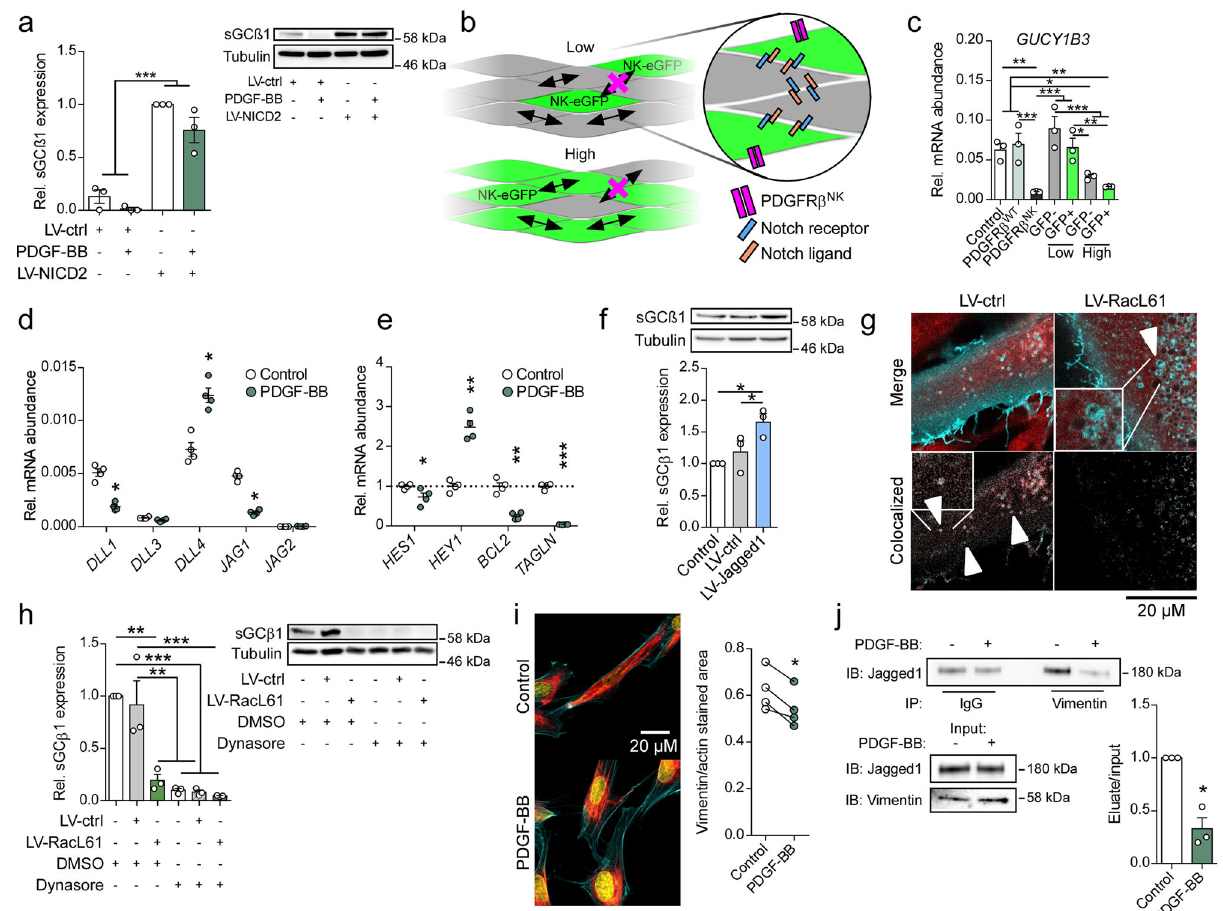
Fig. 3 PDGF/Rac1 reduces sGC expression by interfering with Notch ligand signaling. a Western blot analysis of sGCß1 protein levels in N2ICD- expressing hASMCs with or without treatment PDGF-BB; ANOVA with Tukey ’ s multiple comparisons test; n = 3 independent experiments. b Schematic of mosaic cell culture model used to differentiate between signal-sending and signal-receiving cells (NK: PDGFR β NK ). c qPCR analysis of GUCY1B3 expression in mosaic cell culture model of WT and PDGFR β WT /PDGFR β NK -expressing hVSMCs; ANOVA with Tukey ’ s multiple comparisons test; n = 3 independent experiments. d qPCR analysis of Notch ligand expression in hASMCs treated with PDGF-BB; Multiple t tests with Holm – Sidak ’ s correction for multiple comparisons; n = 4 independent experiments. e qPCR analysis of Notch target genes in hASMCs treated with PDGF-BB; Multiple t tests with Holm – Sidak ’ s correction for multiple comparisons; n = 4 independent experiments. f Western blot analysis of sGCß1 protein levels after lentiviral transduction with Jagged1 (LV-Jagged1) or control vector (LV-ctrl); ANOVA with Tukey ’ s multiple comparisons test; n = 3 independent experiments. g Colocalization of GFP- tagged Jagged1 (cyan) and mCherry-tagged Rab4a (red) after lentiviral transduction of RacL61 (LV-RacL61, right) or control vector (LV-ctrl, left). Bottom panels show colocalized pixels. Arrows indicate Jagged1 + vesicles. Representative images from 3 independent replicates. h Western blot analysis of sGCß1 protein levels in hASMCs after lentiviral transduction with RacL61 (LV-RacL61) or control vector (LV-ctrl) with or without concomitant treatment with Dynasore (50 µ M); ANOVA with Tukey ’ s multiple comparisons test; n = 3 independent experiments. i Immunostaining for Vimentin (red, actin in cyan, nucleus in yellow) after treatment with PDGF-BB (left, representative images from 4 independent replicates) and calculated ratio of vimentin-to-actin stained area (right); t test; n = 4 independent experiments. j Co-immunoprecipitation of Jagged1 and Vimentin in hASMCs with or without treatment with PDGF-BB; t test; n = 3 independent experiments. Bars indicate means± SEM. * p < 0.05, ** p < 0.01, *** p <